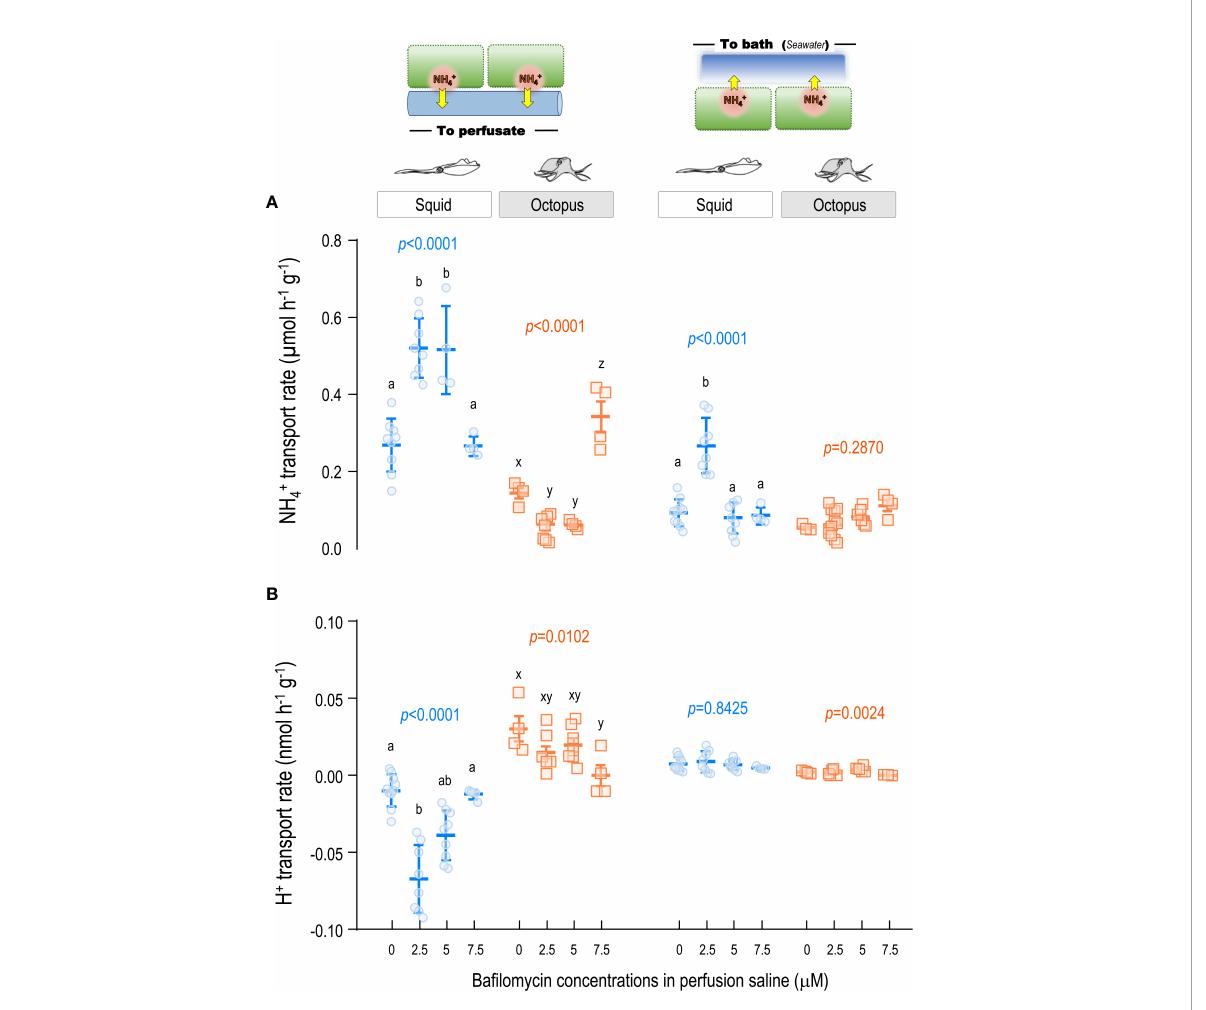
FIGURE 5 Effects of VHA inhibitor ba fi lomycin on the NH 4+ and H + transport rates in gill epithelium of squid and octopus by ex-vivo perfusion approach. Different dosages of the VHA inhibitor ba fi lomycin were tested for their effects on the NH 4+ (A) and H + (B) transport rates in squid and octopus gills by ex-vivo perfusion. Different letters indicate signi fi cant differences among perfused inhibitor dosages ( p < 0.05; One-way ANOVA, Tukey ’ s pairwise